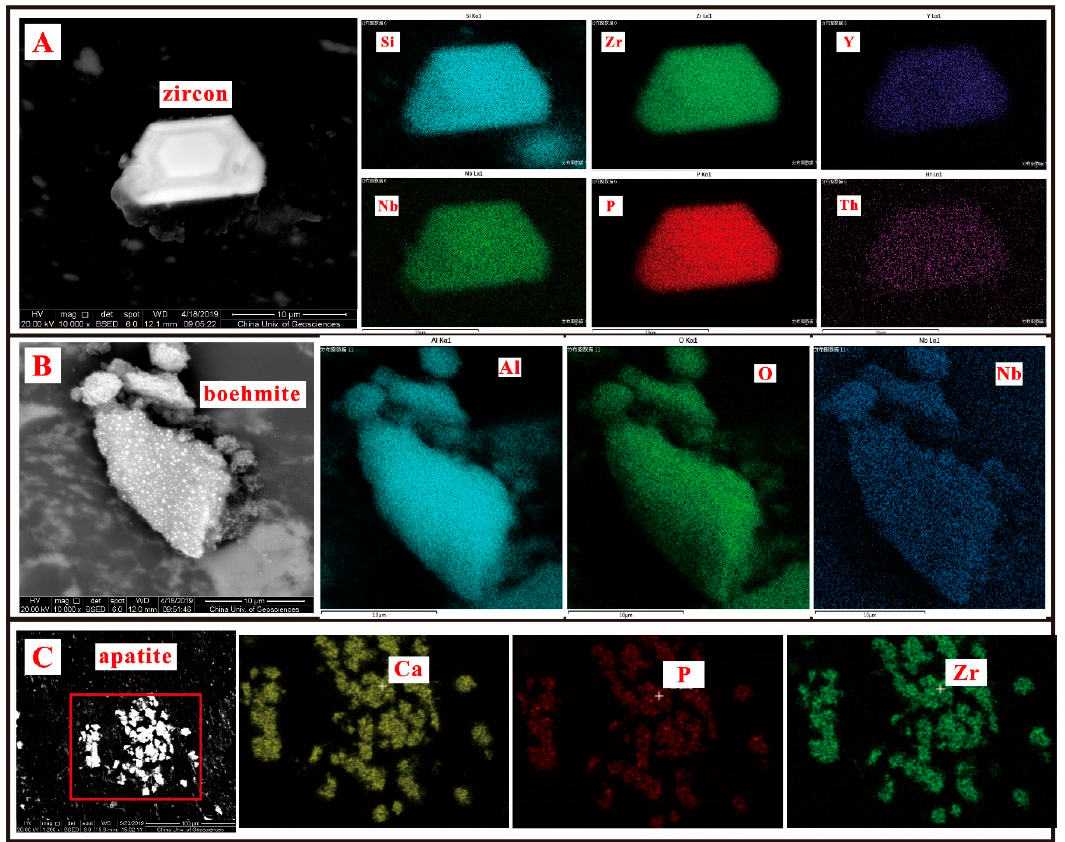
Figure 9. SEM-EDS mappings of zircon ( A ), boehmite ( B )and apatite ( C ) in the coal sample of PR-4-6.